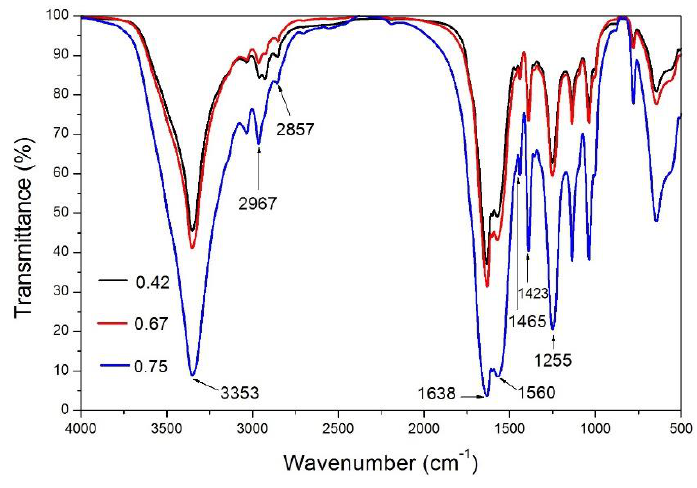
ff erent core-wall Figure 2. FTIR of microcapsules with different core-wall ratios. Figure 2. FTIR of microcapsules with di Figure 2. FTIR of microcapsules with different core-wall ratios.